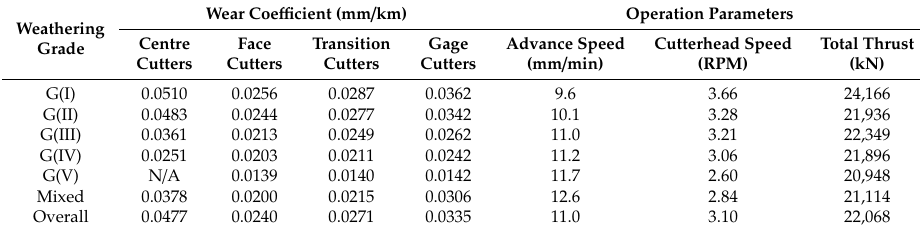
Table 4. Wear coe ffi cient of disc cutters.